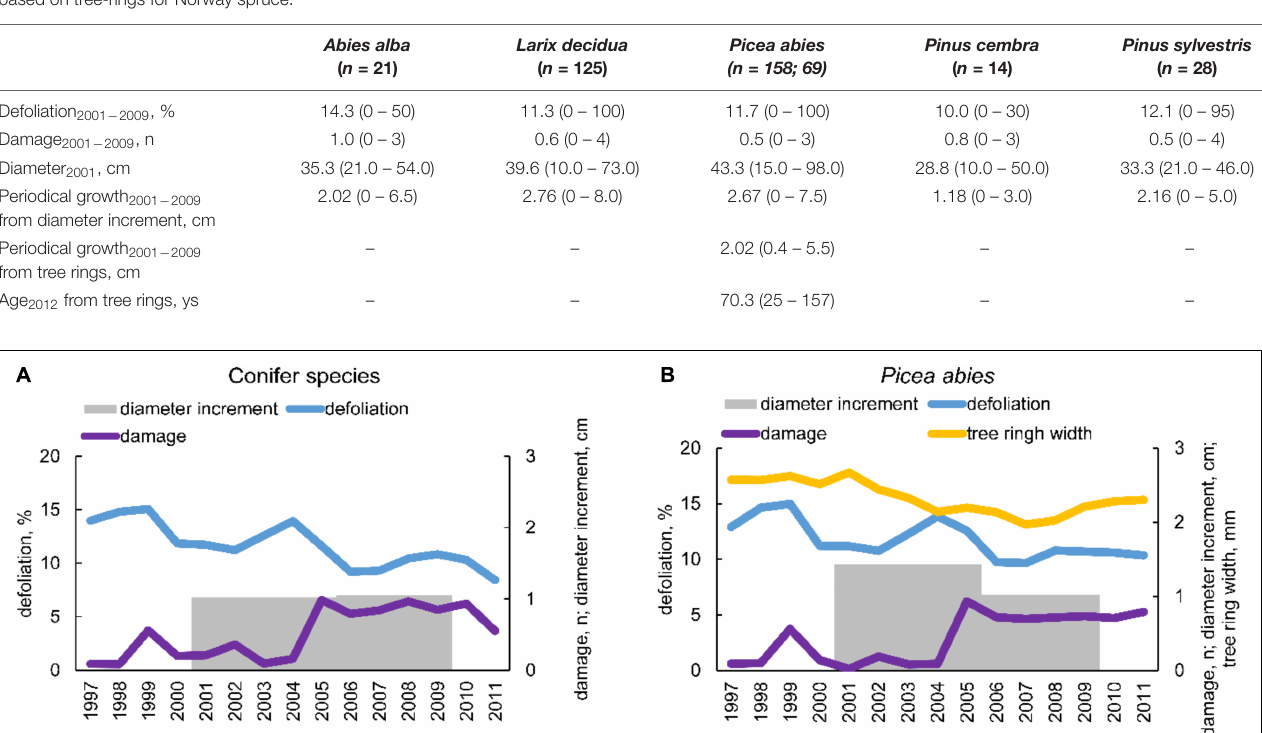
TABLE 3 | Mean (min – max) values of defoliation, damage, tree diameter, periodical growth based on diameter increment for all species, and periodical growth and age based on tree-rings for Norway spruce.